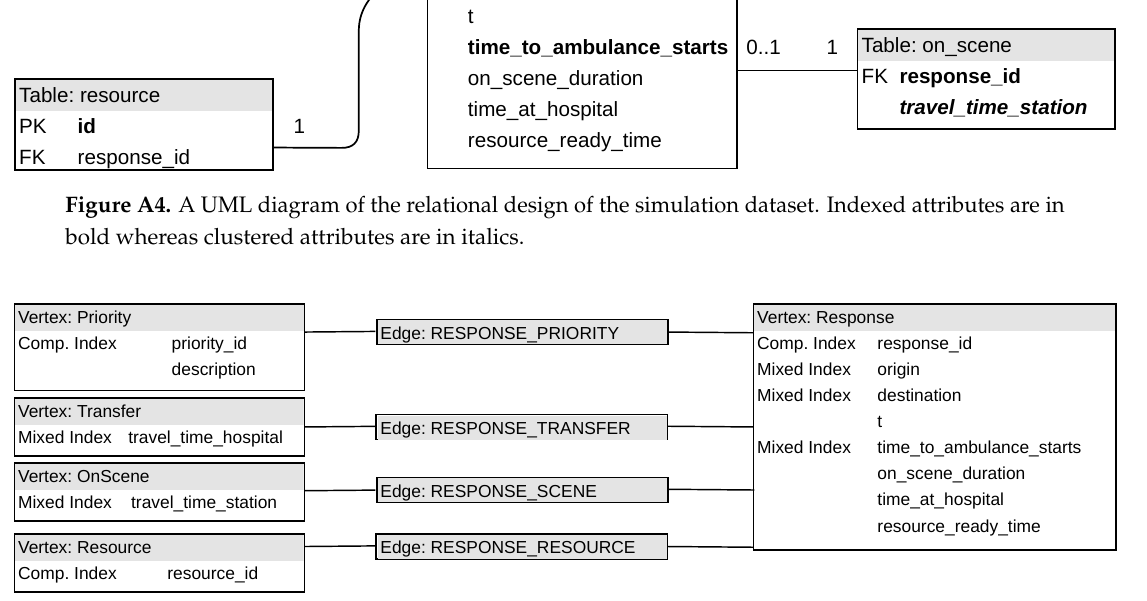
Figure A5. A UML diagram of the graph design of the simulation dataset in JanusGraph.